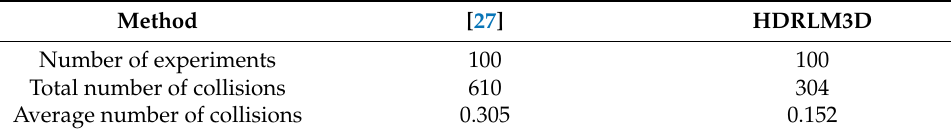
Table 5. Performance comparison of the methods in scenario